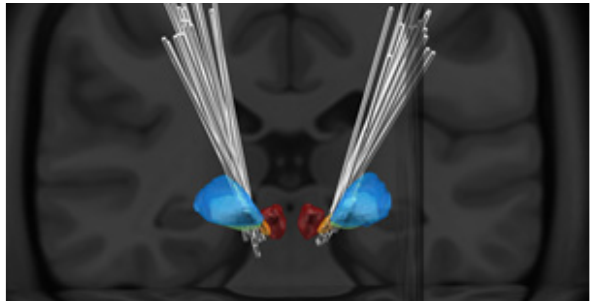
Fig. 3. Group level visualisation (Lead-DBS toolbox